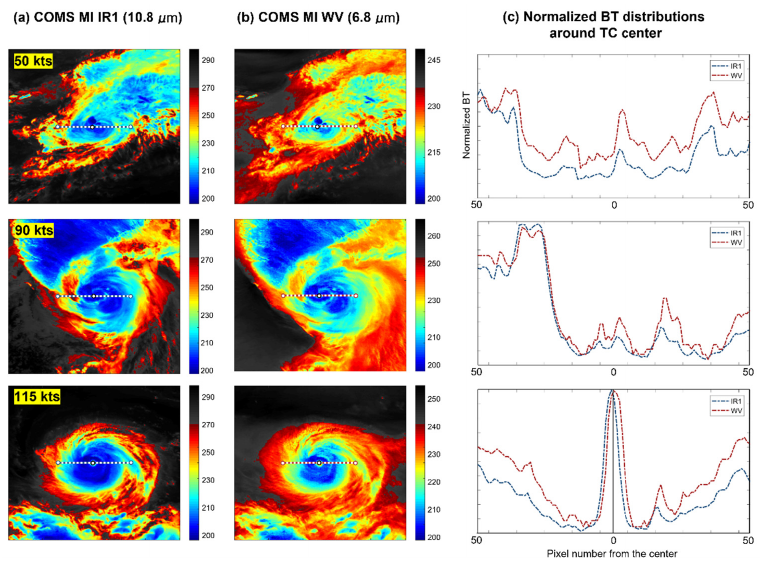
Figure 1. Intensity-wise tropical cyclones observed from Communication, Ocean and Meteorological Satellite Meteorological Imager in 2017: typhoon NANMADOL with 50 kts wind speed (first row), typhoon LAN with 90 kts wind speed (second row), and typhoon NORU with 115 kts wind speed (third row). ( a , b ) show infrared-1- and water-vapor-channel-based images, respectively, and ( c ) represents the normalized brightness temperature distribution of the horizontal line with 101 pixels (approximately 404 km; dotted lines in ( a , b )) across the tropical cyclone center.